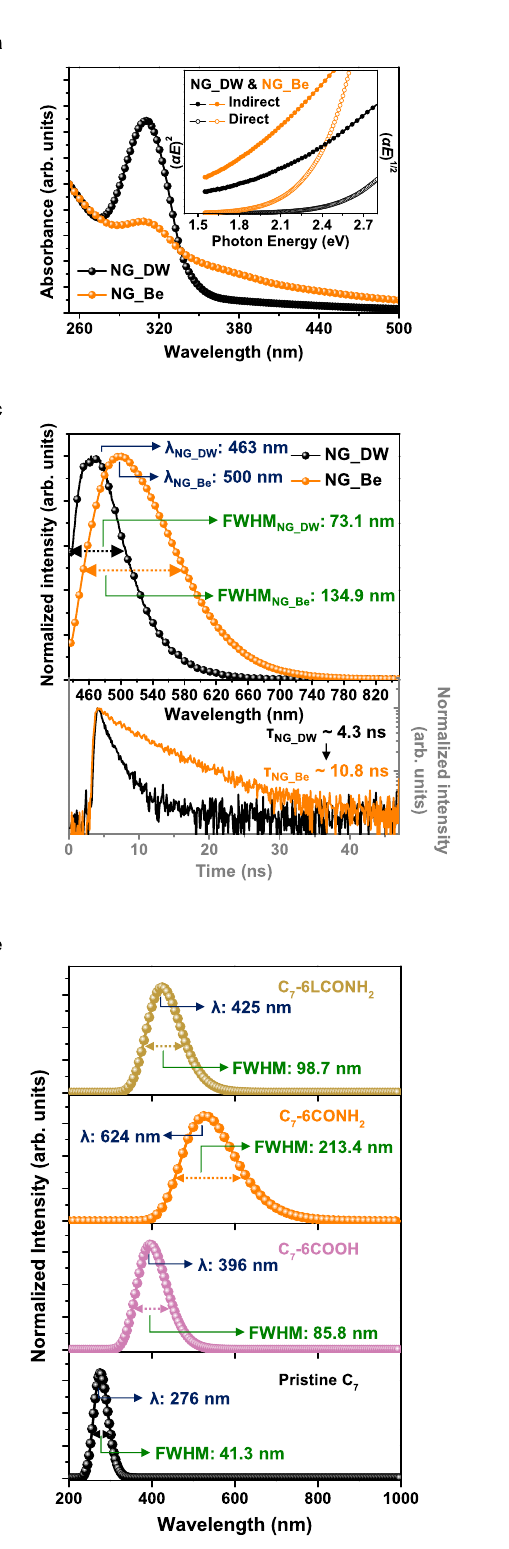
Fig. 14. These shifts can be ascribed to changes in the f values of the electronic transitions caused by the distorted molecular symmetry as well as the different electron distribution in the graphene moieties 26 . Speci fi cally, depending on the oscillator strengths of S 0 → S n for C 7 -GQDs in Fig. 4b, the enhanced absorption capacity at longer wavelengths (350 – 500 nm) is signi fi cantly affected by the